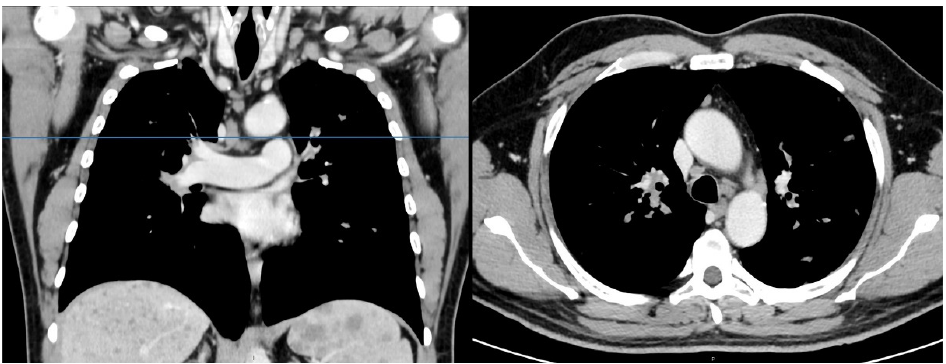
Figure 1. Chest computed tomography showed multiple peribronchovascular nodules, mainly located in the upper lobes.